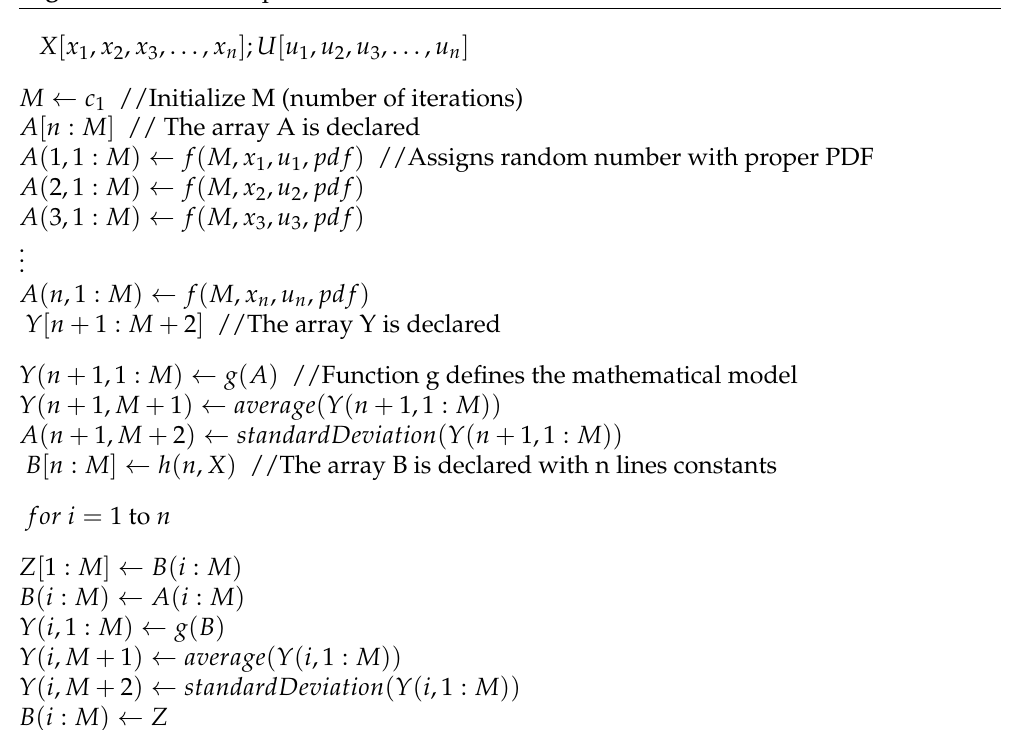
Algorithm 1 MCM